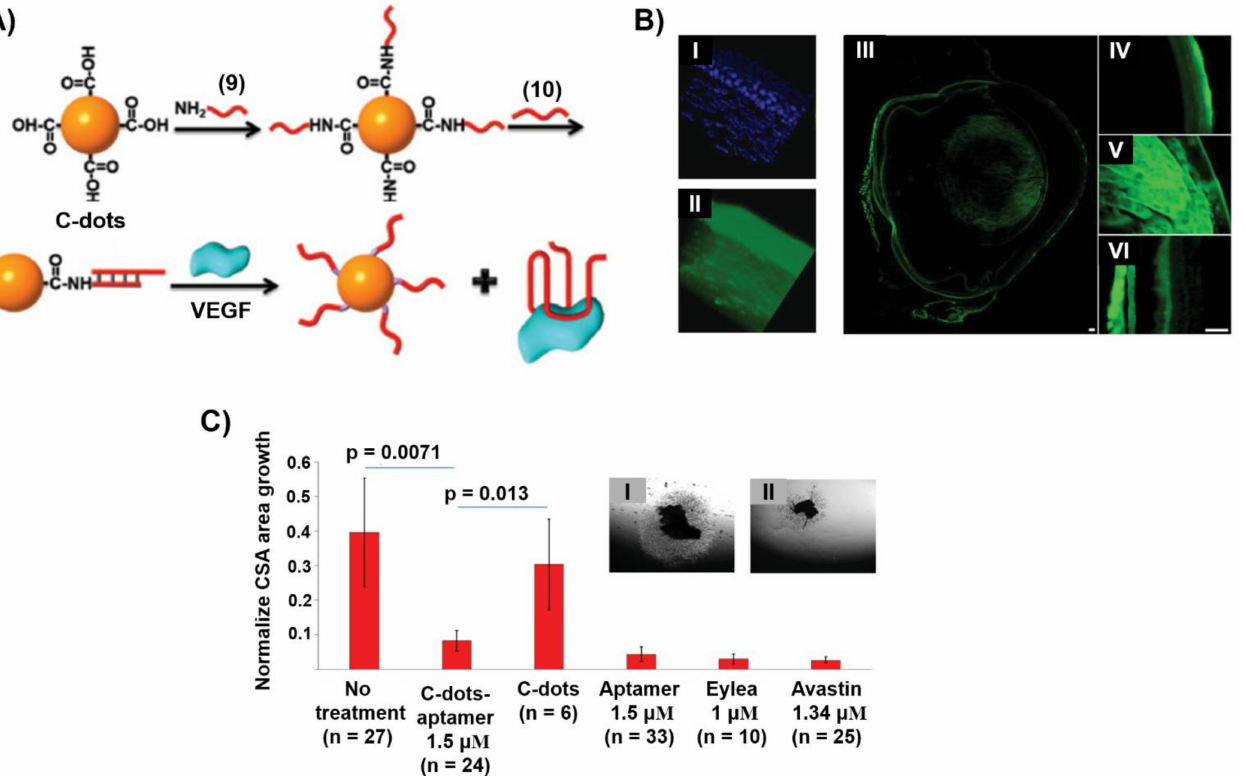
Figure 10. ( A ) VEGF aptamer-modified C-dots as functional carriers for the VEGF-induced release of the aptamer and the formation of VEGF/VEGF aptamer complexes that inhibit the angiogenetic function of VEGF. ( B ) Penetration of C-dots into the various eye structures and noninvasive monitoring of the intraocular concentration of C-dots following topical administration. C-dots topically applied on the cornea penetrated all eye layers and structures. Confocal microscopy of a cornea topically treated with C-dots exhibiting characteristic C-dots high fluorescence in the corneal epithelium and stroma (I, II). A gross histology of the eye showing a wide distribution of the C-dots along the entire eye structures (III), including the cornea (IV), the lens (V) and vitreous, retina and choroid (VI) ( C ) Results probing the angiogenetic effect of the VEGF aptamer-modified C-dots in comparison to commercial therapeutic drugs. Inset. Panel I-growth and sprouting of the blood vessel in choroids treated with C-dots lacking the VEGF aptamer. Panel II-inhibition of blood vessel sprouting in choroids treated with the VEGF aptamer-modified C-dots. Reproduced with permission from ref. [170]. Copyright 2019